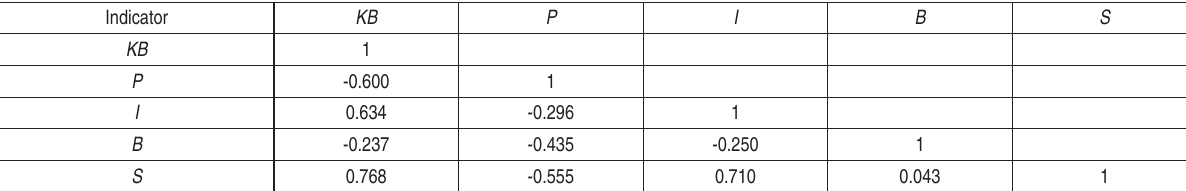
Table 2. The matrix of coefficients of pair correlation to the number of banks